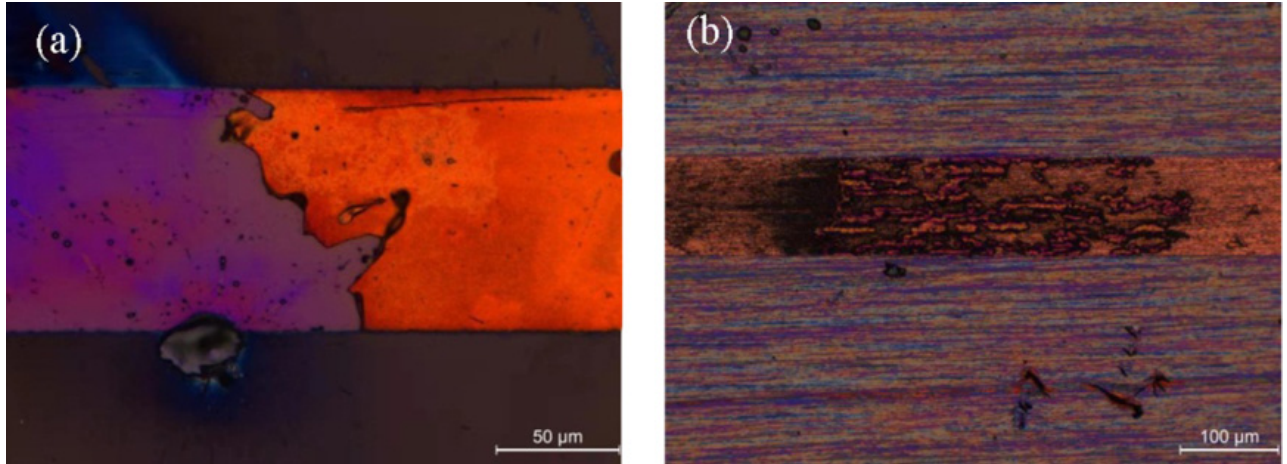
Figure 6. The optical microscope photos of wires after current-carrying, ( a ) The shedding of pure Cu wire caused by high temperature, ( b ) CNT–Cu composite wire after burning.